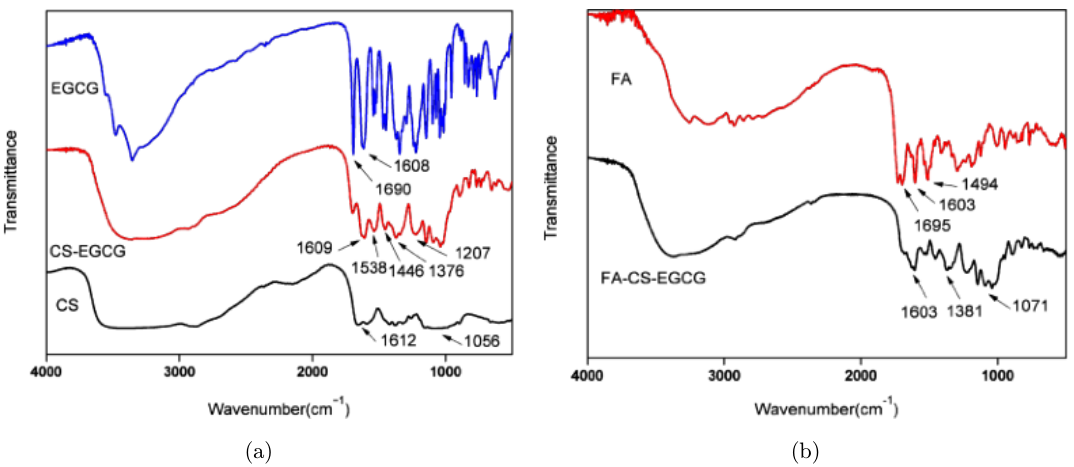
Fig. 2. FT-IR spectra of (a) EGCG, CS and CS-EGCG, (b) FA and